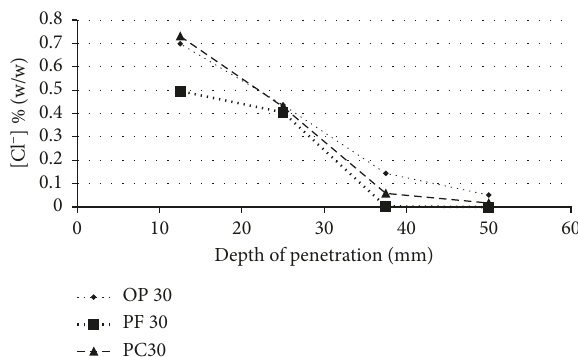
Figure 4: Results for chloride ingress versus depth from exposed surface test cements at 0.8 w/c ratio.